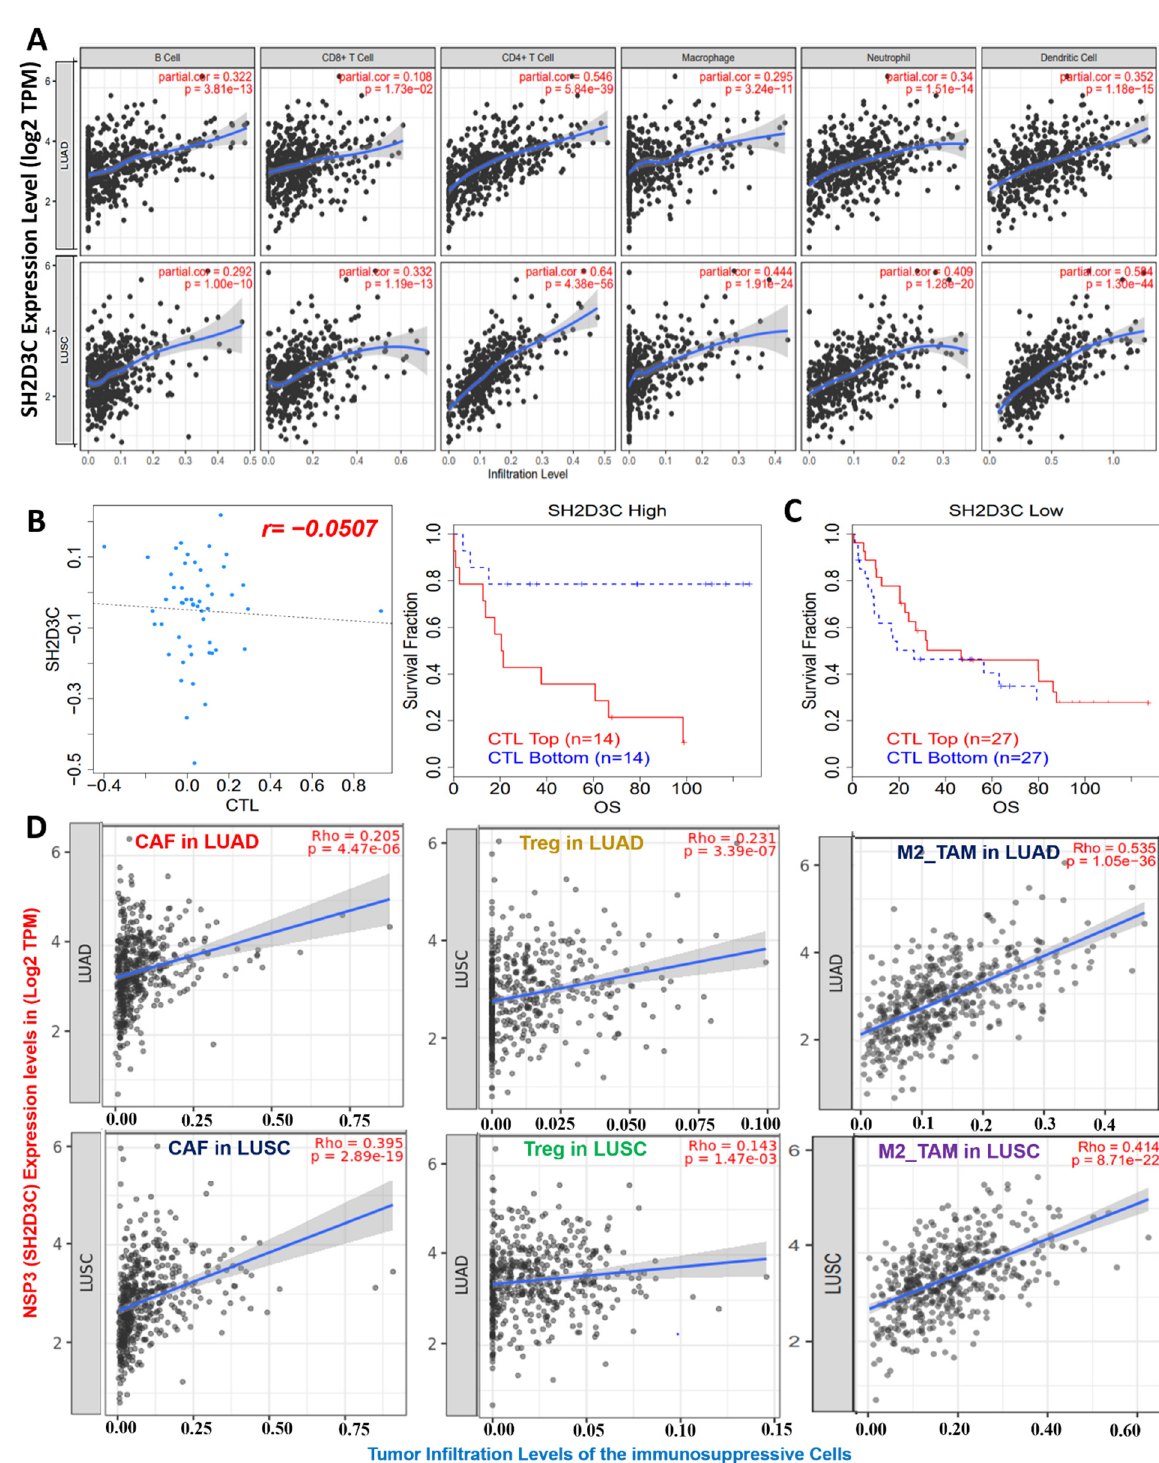
Figure 4. Non-structural protein 3 ( NSP3; SH2D3C ) promotes dysfunctional T-cell phenotypes in lung cancer patients. ( A ) Scatterplot showing correlations between NSP3 (SH2D3C) expression and infiltration of various immune cells in lung adenocarcinoma (LUAD) and lung squamous cell carcinoma (LUSC). ( B ) Correlation analysis between NSP3 (SH2D3C) expression and cytotoxic T lymphocyte (CTL) levels in lung cancer patients. ( C ) Kaplan–Meier plot of the overall survival of lung cancer patients with different NSP3 (SH2D3C) and CTL levels. ( D ) Boxplot showing NSP3 (SH2D3C) expression corre- lations with infiltration levels of immunosuppressive cells, including cancer-associated fibroblasts (CAFs), M2 macrophages, and regulatory T cells in LUAD